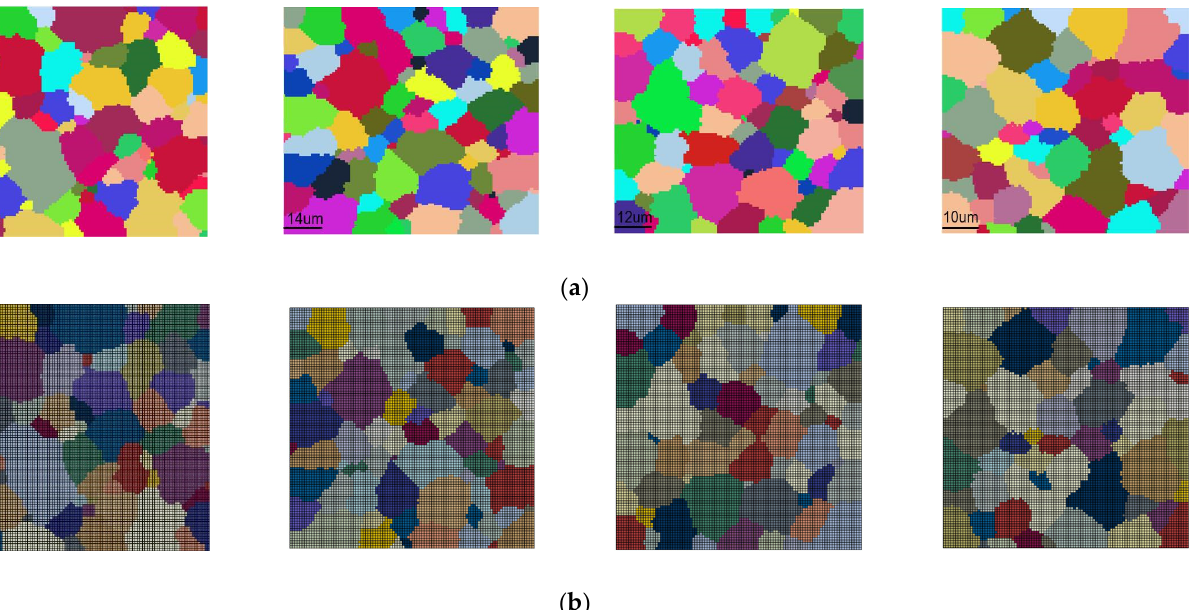
Figure 7. Projection from Monte Carlo model to crystal plasticity model [138]. ( a ) Monte Carlo model and ( b ) crystal plasticity model. (Reprinted/adapted with permission from Ref. [138], 2020, Zhao Zhang).